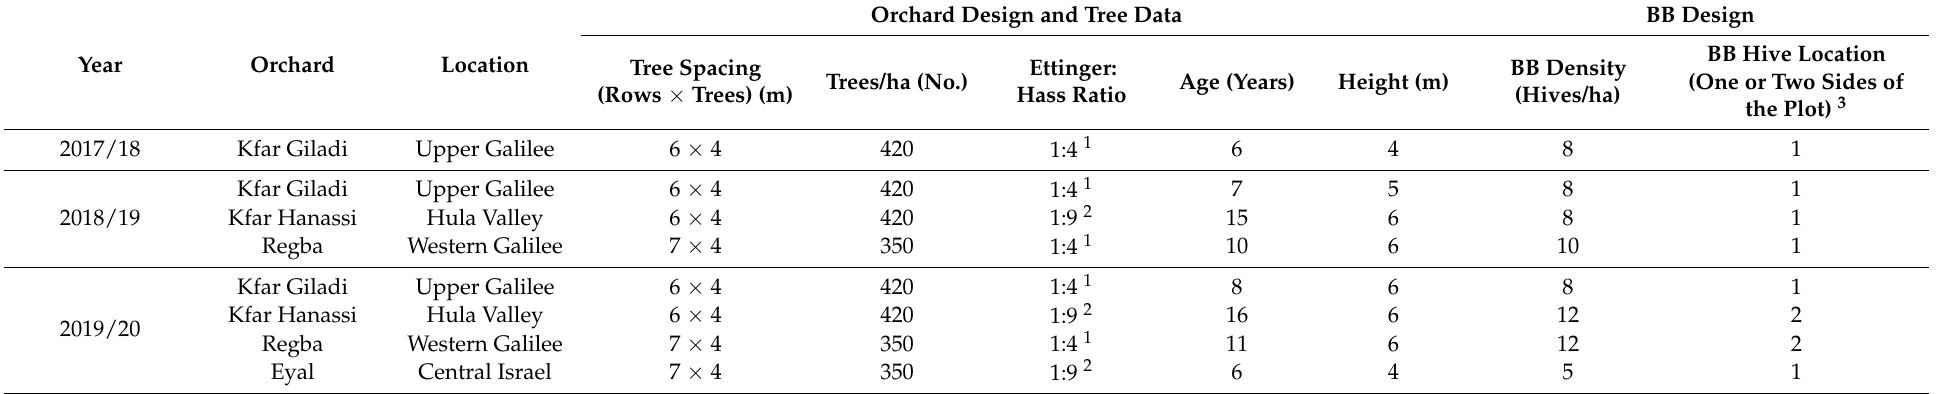
Table 1. Avocado plots used for bumblebee (BB) pollination experiments during the years